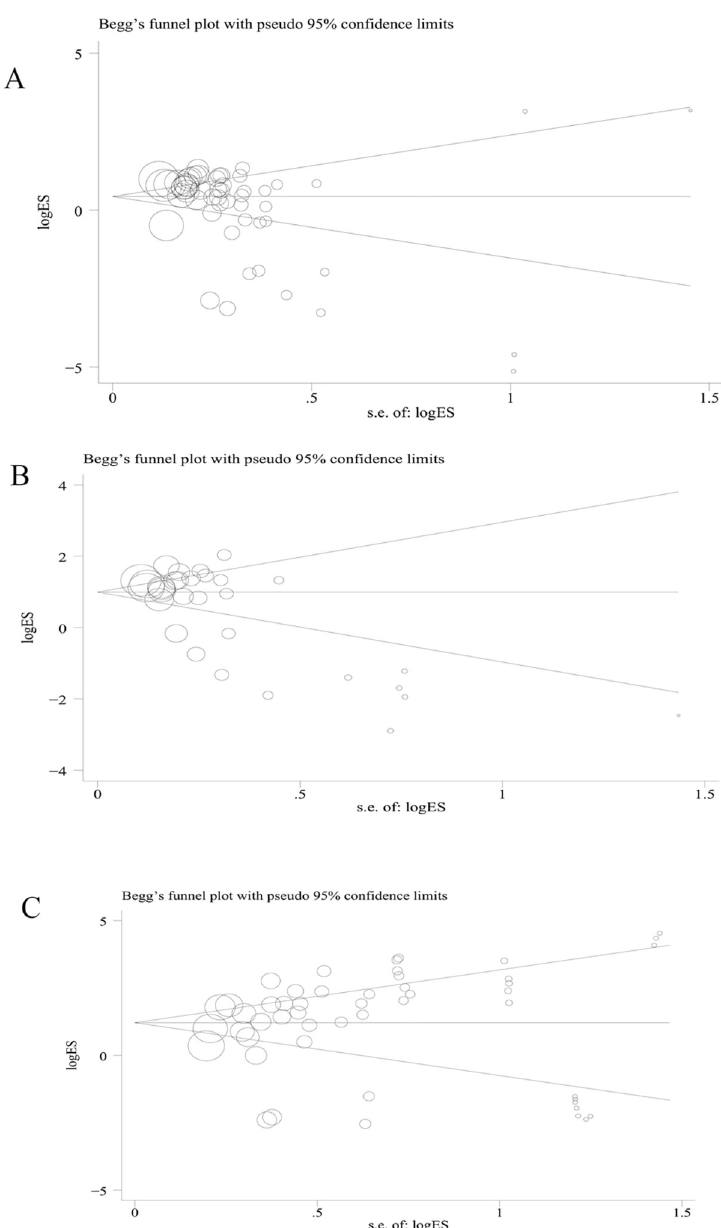
Fig 8. (A) Begg’s funnel plot of publication bias for LOXL1 gene polymorphism rs1048661; (B) Begg’s funnel plot of publication bias for LOXL1 gene polymorphism rs2165241; (C) Begg’s funnel plot for of publication bias for LOXL1 gene polymorphism